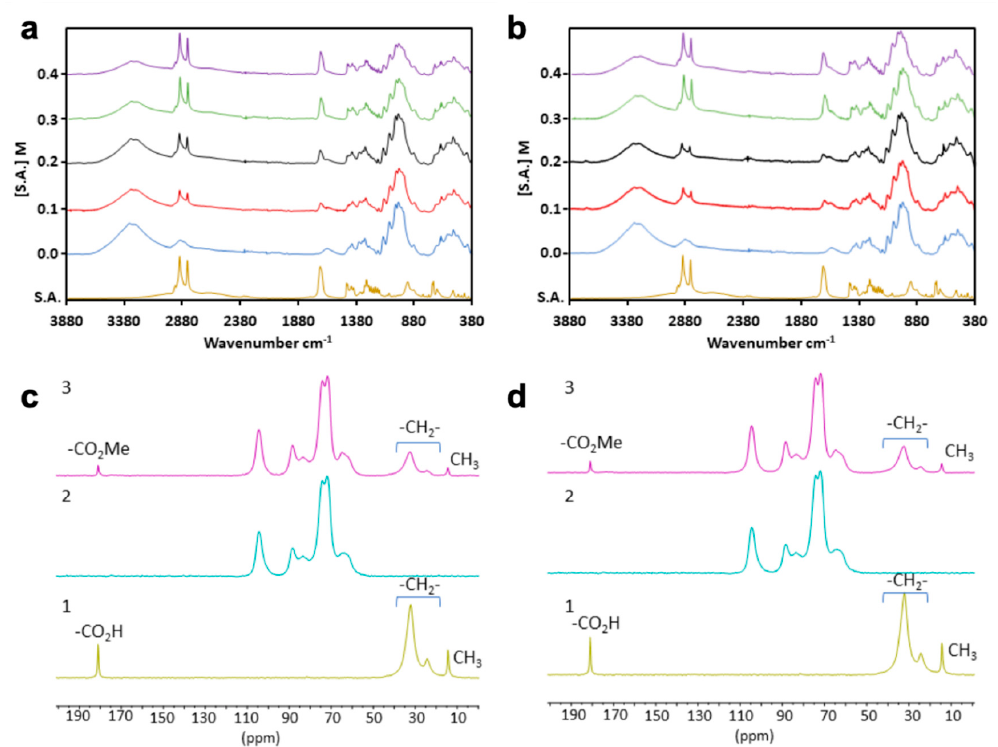
Figure 11. FTIR and NMR spectra for flax modified by stearic acid. ( a ) (Ethanol) and ( b ) (toluene) FTIR spectra ([SA] = 0.1, 0.2, 0.3, and 0.4 M). 13 C CP/MAS NMR spectrum of stearic acid 1 (SA), flax fabric (blue) 2, and, in purple, the flax fabric treated with 0.4 M of SA in ethanol ( c ) and in toluene ( d ).